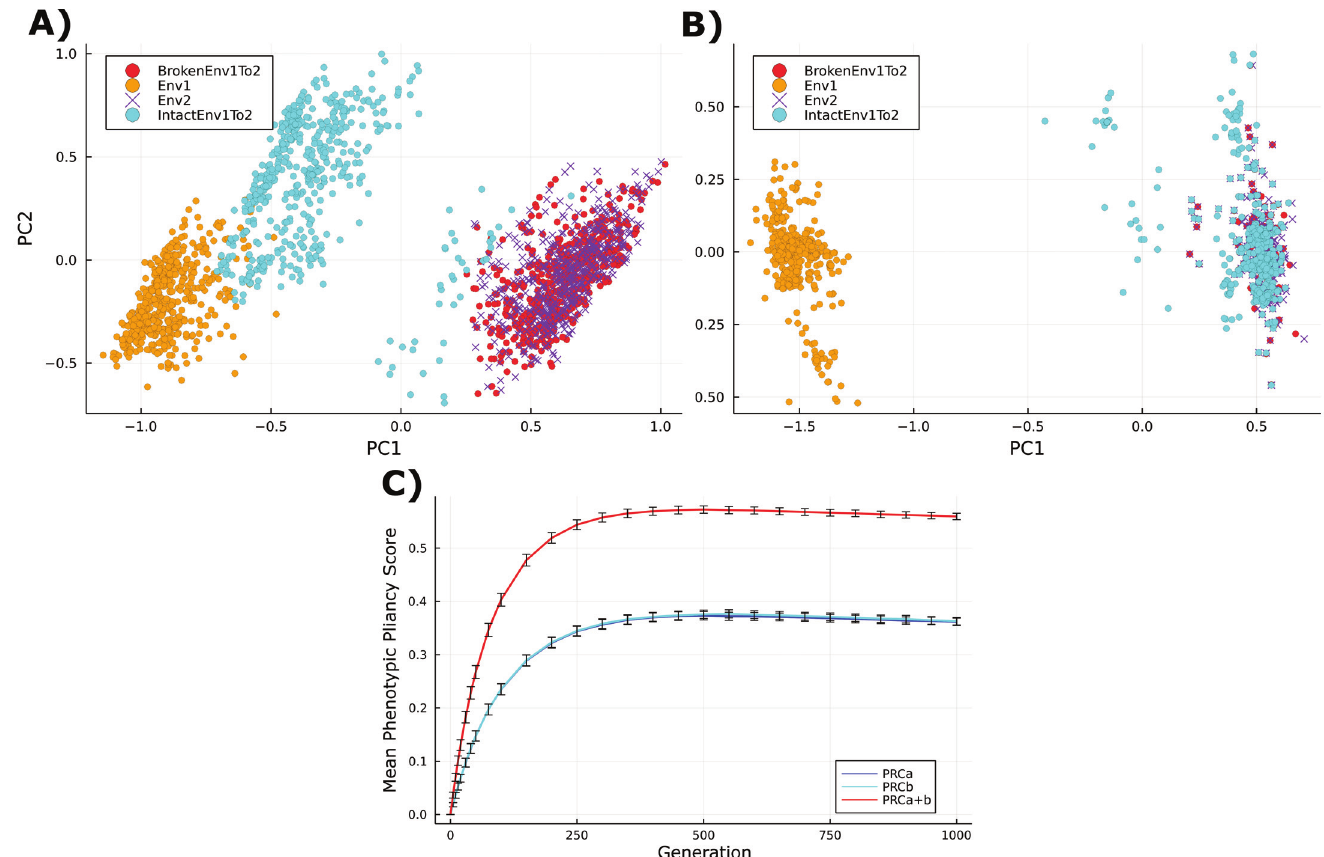
Fig 3. Phenotypic pliancy and fidelity results from computational model. A . PCA results for all individuals in population at the end of evolution (after generation 1,000) when polycomb mechanisms have more fully evolved to visually assess phenotypic pliancy. When transfer from environment 1 to environment 2, only the case when polycomb mechanisms are broken and switched to environment 2 (red) alter their phenotypes to resemble that of environment 2 that moved to (purple X’s). The individuals with polycomb mechanisms left intact and moved to environment 2 (cyan) have phenotypes that do not switch and resemble more closely environment 1 that moved from (orange). B . Principle Componenet Analysis (PCA) results for all individuals in population right after generation 50 during evolution when polycomb mechanisms have not more fully evolved to visually assess phenotypic pliancy. When transfer from environment 1 to environment 2, both the cases when polycomb mechanisms are left intact (cyan) and broken (red) alter their phenotypes to resemble that of environment 2 that moved to (purple X’s). C . Average phenotypic pliancy score when vary degree of PcG-like mechanisms dysregulation during evolution for all 10,000 populations when move from environment 1 to environment 2 to quantitatively assess pliancy. We vary degree of dysregulation by breaking PRCa alone (blue), PRCb alone (cyan), or both PRCa and b (red) for all 10,000 populations for a total of 10 million simulated cells pliancy score averaged (y-axis) for different generations throughout evolution (x-axis).